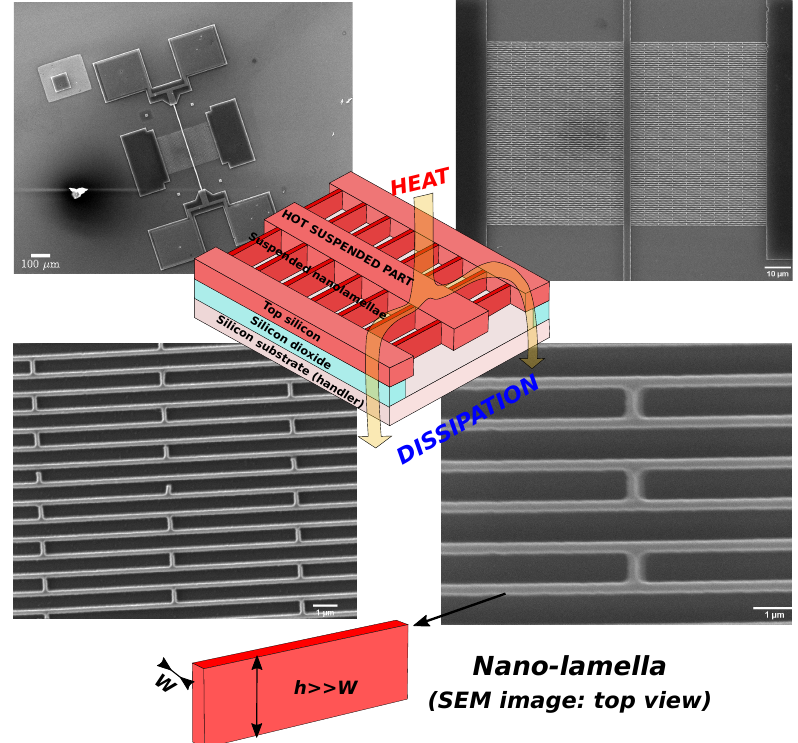
Figure 6. Original SEM micrographs of fabricated prototypes, together with a sketch of these planar thermoelectric devices. These prototypes confirm the feasibility of an all-silicon thermoelectric device, based on large arrays of silicon